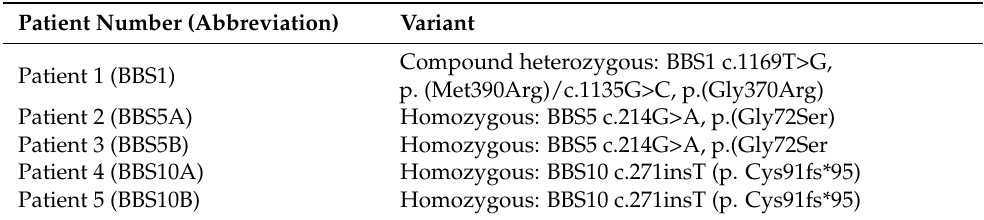
Table 1. Variant information on the used patient